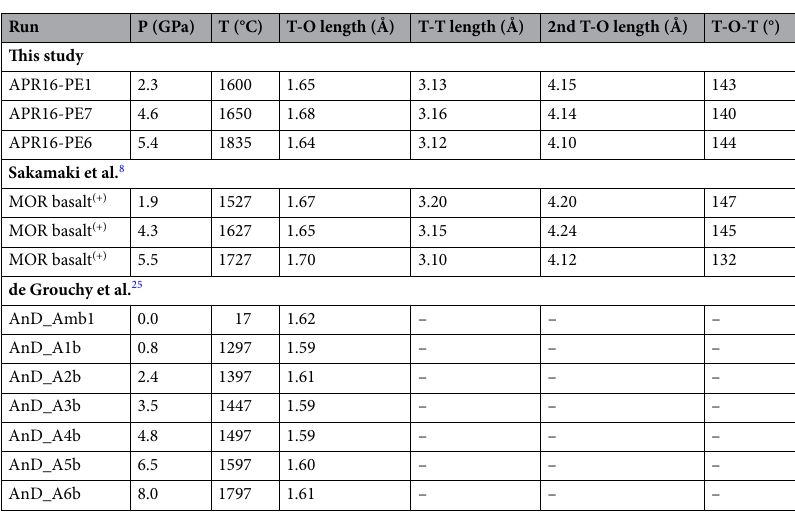
Table 2. Experimental conditions of melt structure measurements in this and previous studies.